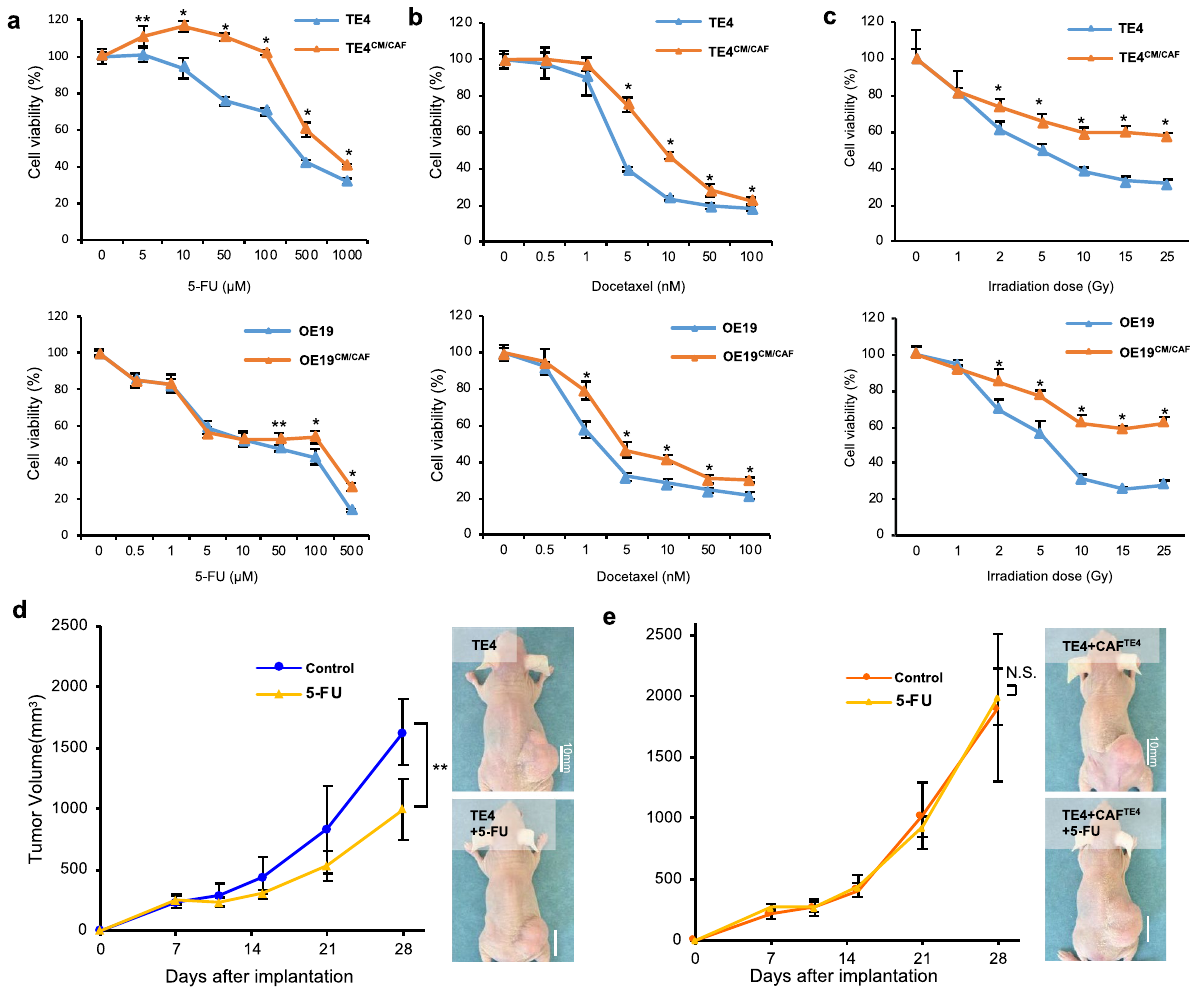
Figure 1. Tumor cells stimulated with CAFs were relatively refractory to conventional therapy in vitro and in vivo. ( a , b ) After 48 h of stimulation with CAF conditioned medium, tumor cells were treated with the indicated concentrations of 5-FU ( a ) and docetaxel ( b ), and cell viability was measured. Stimulated tumor cells (the TE4 CM/CAF or OE19 CM/CAF group) were more resistant to chemotherapy than unstimulated cells. ( c ) Stimulated tumor cells were irradiated with the indicated dose of radiotherapy, and cell viability was measured. Stimulated tumor cells were more resistant to radiotherapy than unstimulated cells. ( d ) The treatment resistance of coinoculated tumors (CAFs and tumor cells) in vivo was evaluated. After inoculation, tumor growth was monitored from day 7 to day 28. ( d ) In the TE4 cells alone group (n = 4), 5-FU suppressed tumor growth in TE4 subcutaneous tumors. ( e ) In the group of mice inoculated with TE4 cells cocultured with CAFs (n = 4), tumors acquired chemoresistance to 5-FU (scale bar, 10 mm). Data are shown as the mean ± SD of three or more independent experiments. Statistical analyses were performed using Student’s t test. * P < 0.05, ** P < 0.01. N.S. indicates no significant